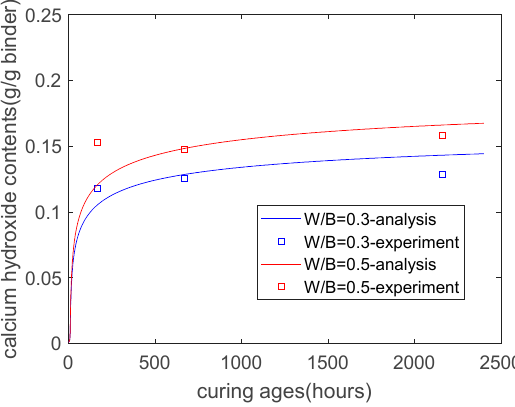
Figure 2. Hydration of neat Portland cement.